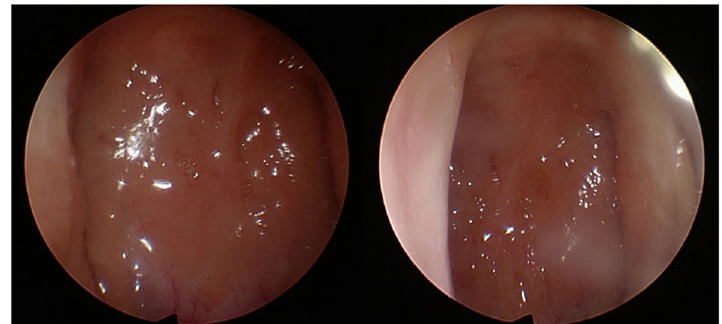
Fig. 3 Endoscopic appearance of the nasopharynx (post-completion of anti-tuberculous treatment), showing resolution of nasopharyngeal